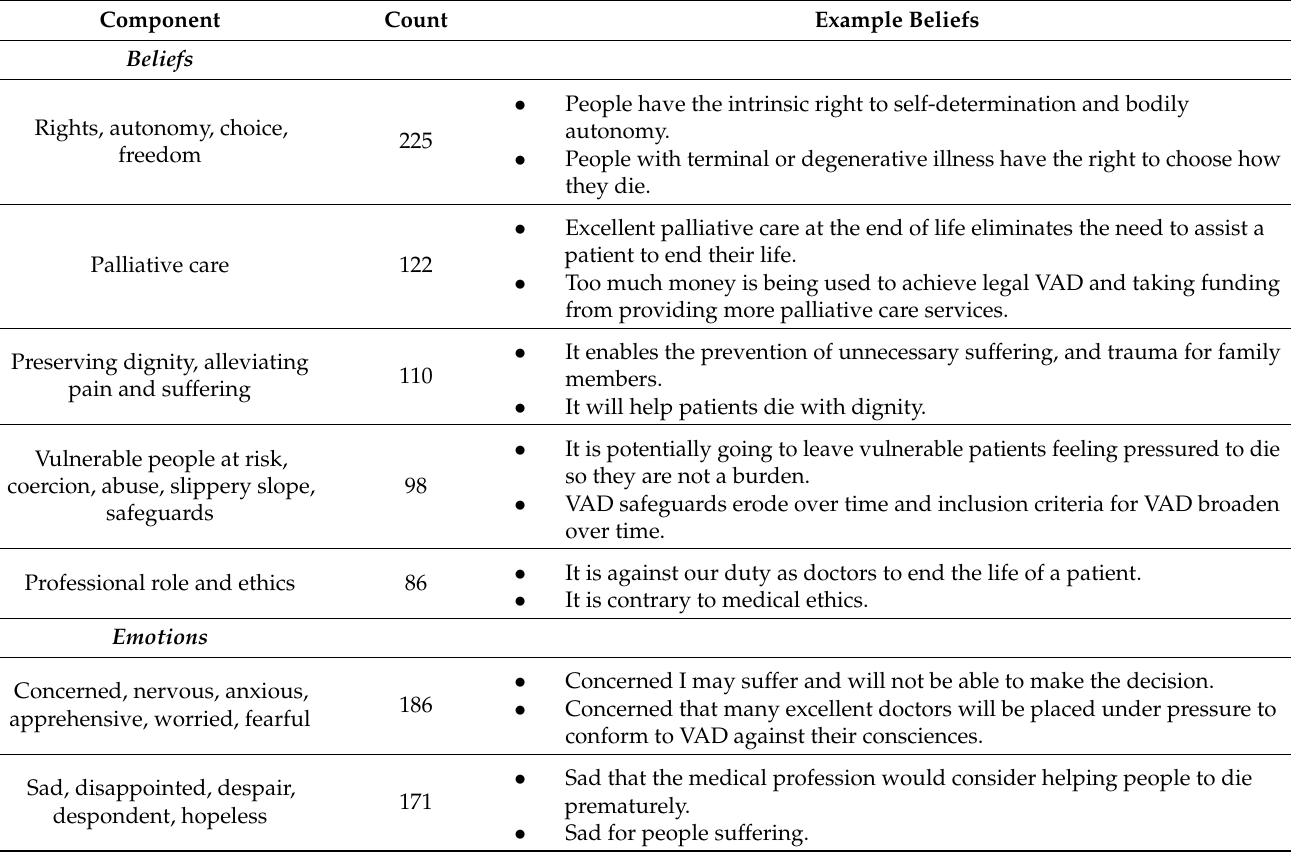
Table 4. Beliefs, Emotions, and Experiences